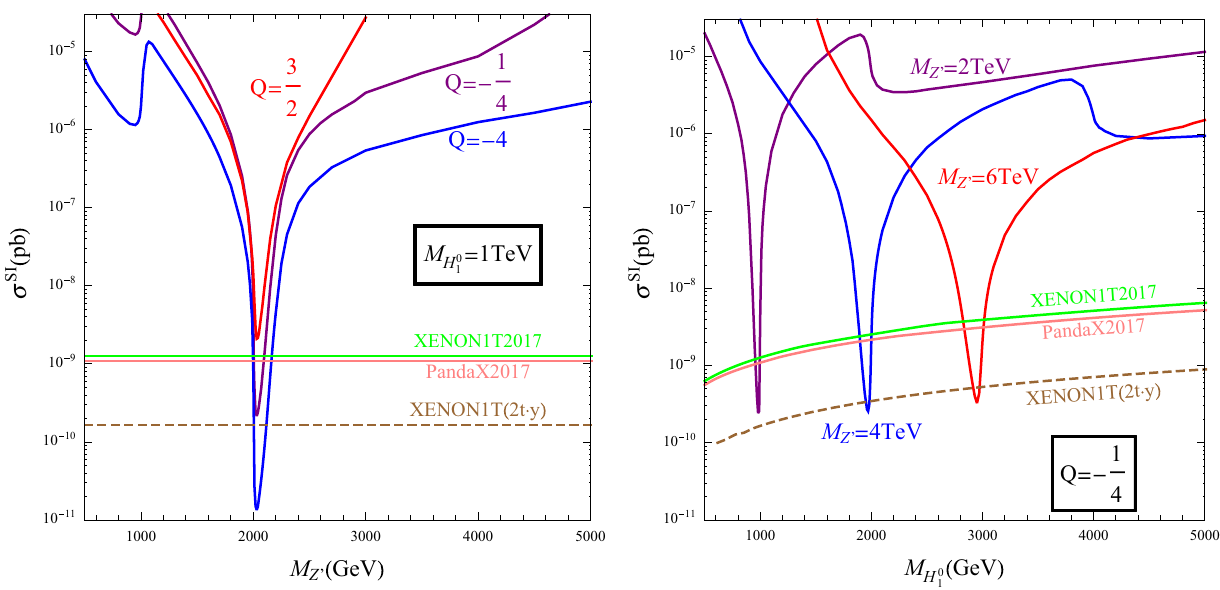
Fig. 8 Spin-independent cross section of scalar DM H 0 nucleon. Left:as afunction of M Z (cid:2) for M Right: as a function of M